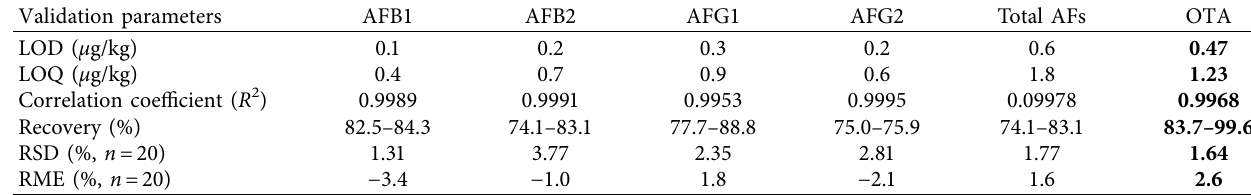
Table 1: Validation parameters for the HPLC determination of AFB1, AFB2, AFG1, AFG2, and OTA. Validation parameters